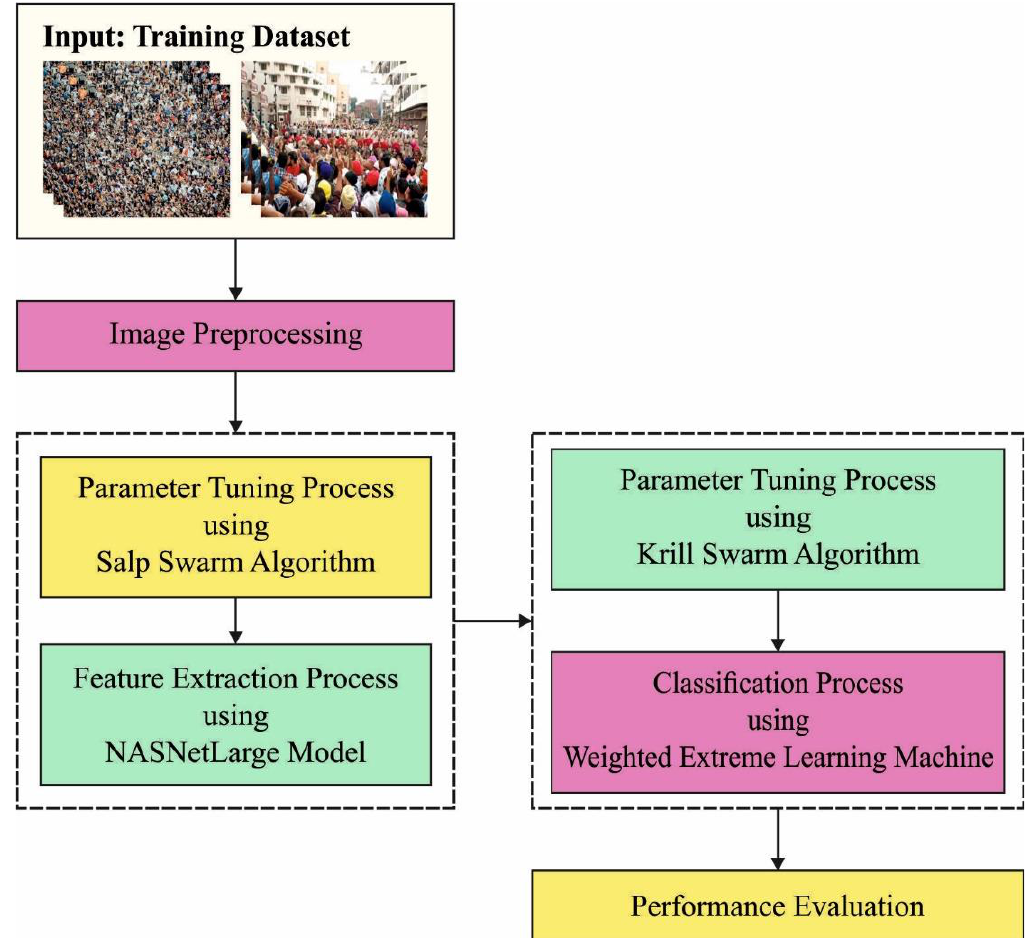
Figure 1. Block diagram of MDTL-ICDDC technique.